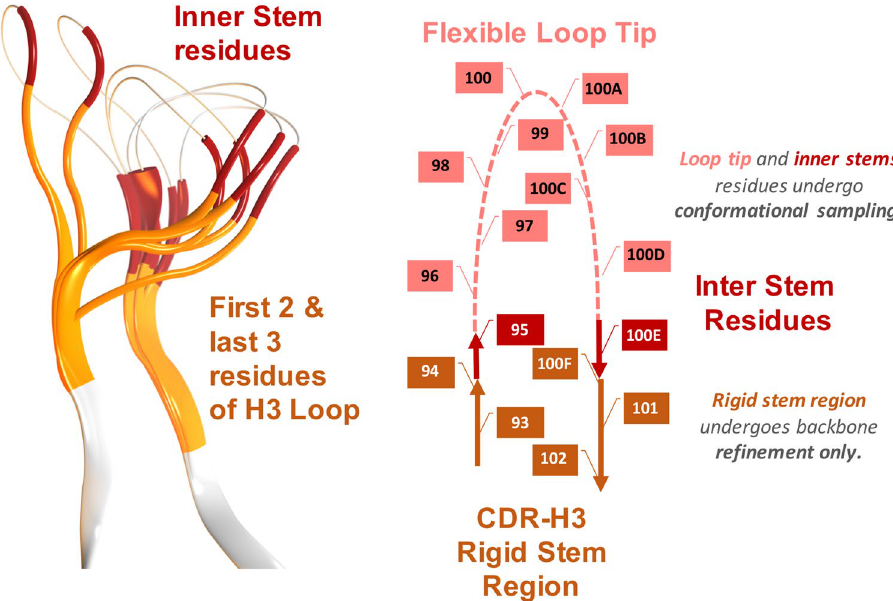
Figure 3. Definition of the H3 stem region for template matching. N- and C-terminal regions of the stem as defined by North et al. are rendered as cartoon, with the remaining inner H3 loop region that needs to be sampled shown as thin line. Larger structural variations for inner ends (red) of the stem led to a shortened stem (yellow) to be used in our